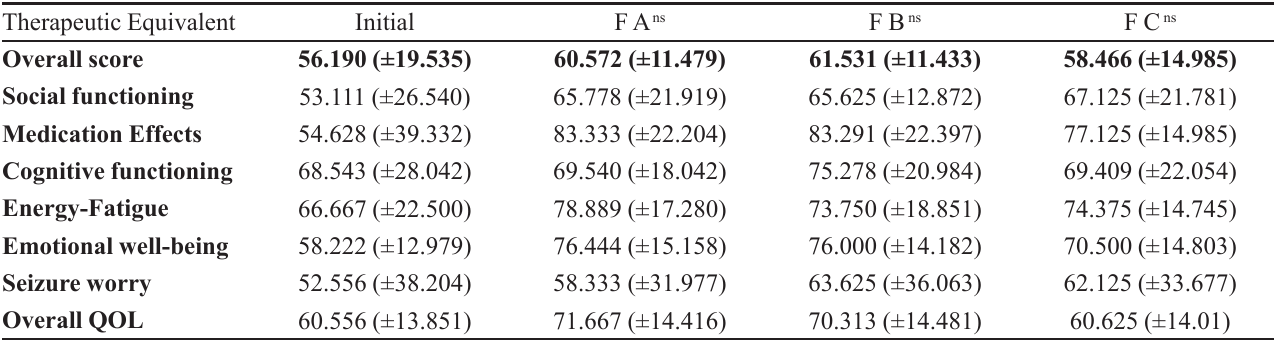
TABLE IV - Mean scores on QOLIE-31 (total and domains) Therapeutic